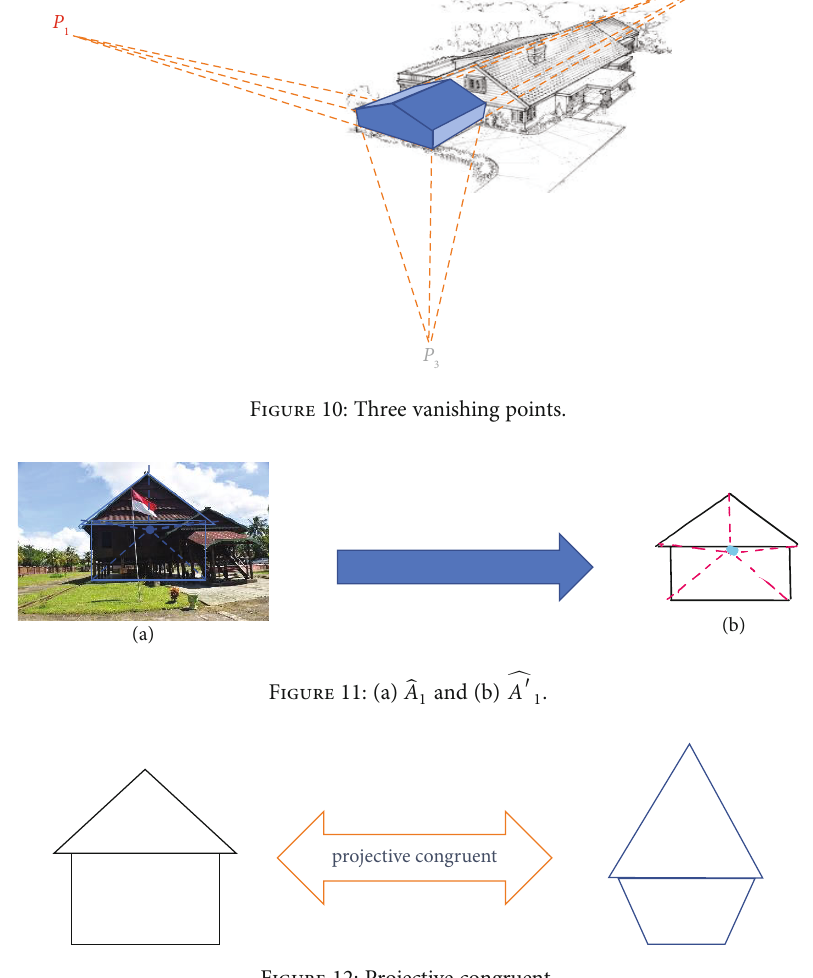
Figure 12: Projective congruent.